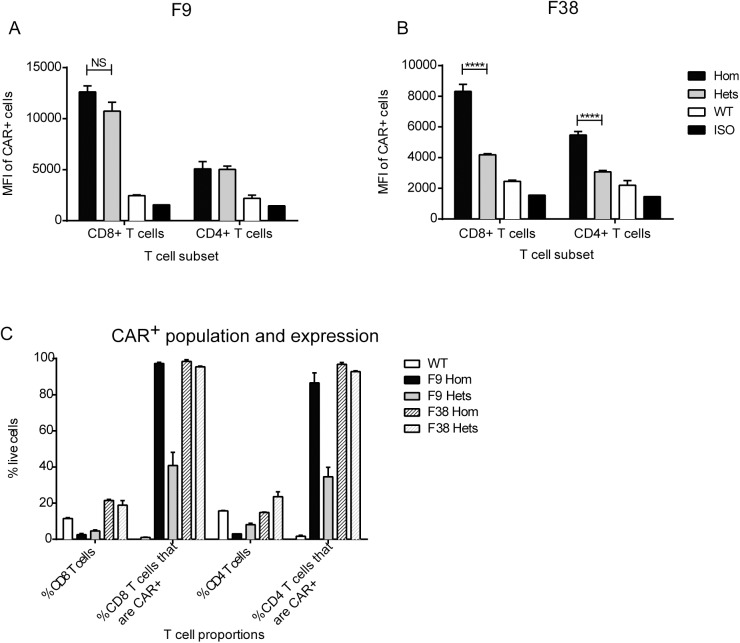
The number of vav-CAR transgenes affects both proportion and expression level of CAR+ cells.Spleens from homozygous and heterozygous vav-CAR mice were harvested and analyzed for the level of receptor expression on resting T lymphocytes. Splenocytes were incubated with Fc receptor block and stained with the following antibodies; TCRβ, CD3, CD4, CD8 and Myc-tag Alexa488. The mean fluorescence intensity (MFI) of CAR expression on F9 mice (A) and F38 mice (B) is depicted. (C) Depicts the percentage of CD4+ and CD8+ subsets in spleens and the percentage of those subsets expressing CAR in homozygous (Hom) and heterozygous (Het) mice. Data represents the mean ± SEM of (WT = 2, Homozygous = 2, Heterozygotes = 7) individual mice. ****p<0.0001, NS = not significant.